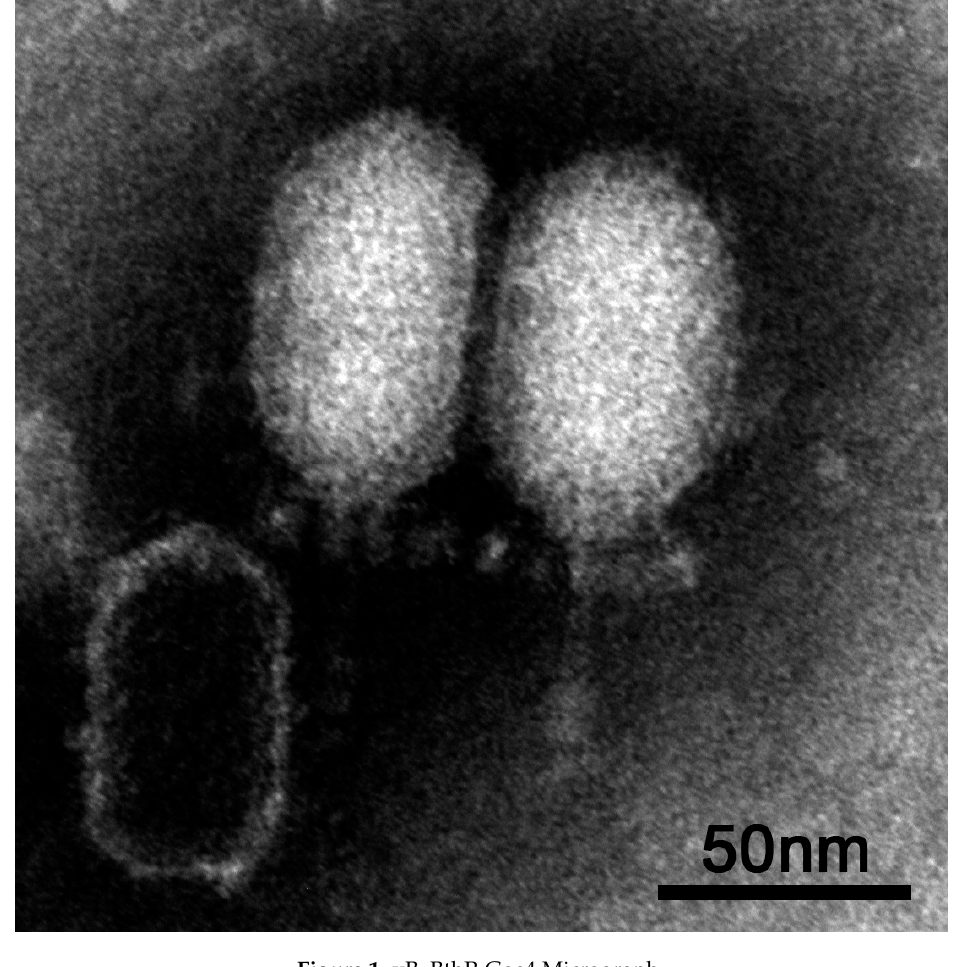
Figure 1. vB_BthP-Goe4 Micrograph.